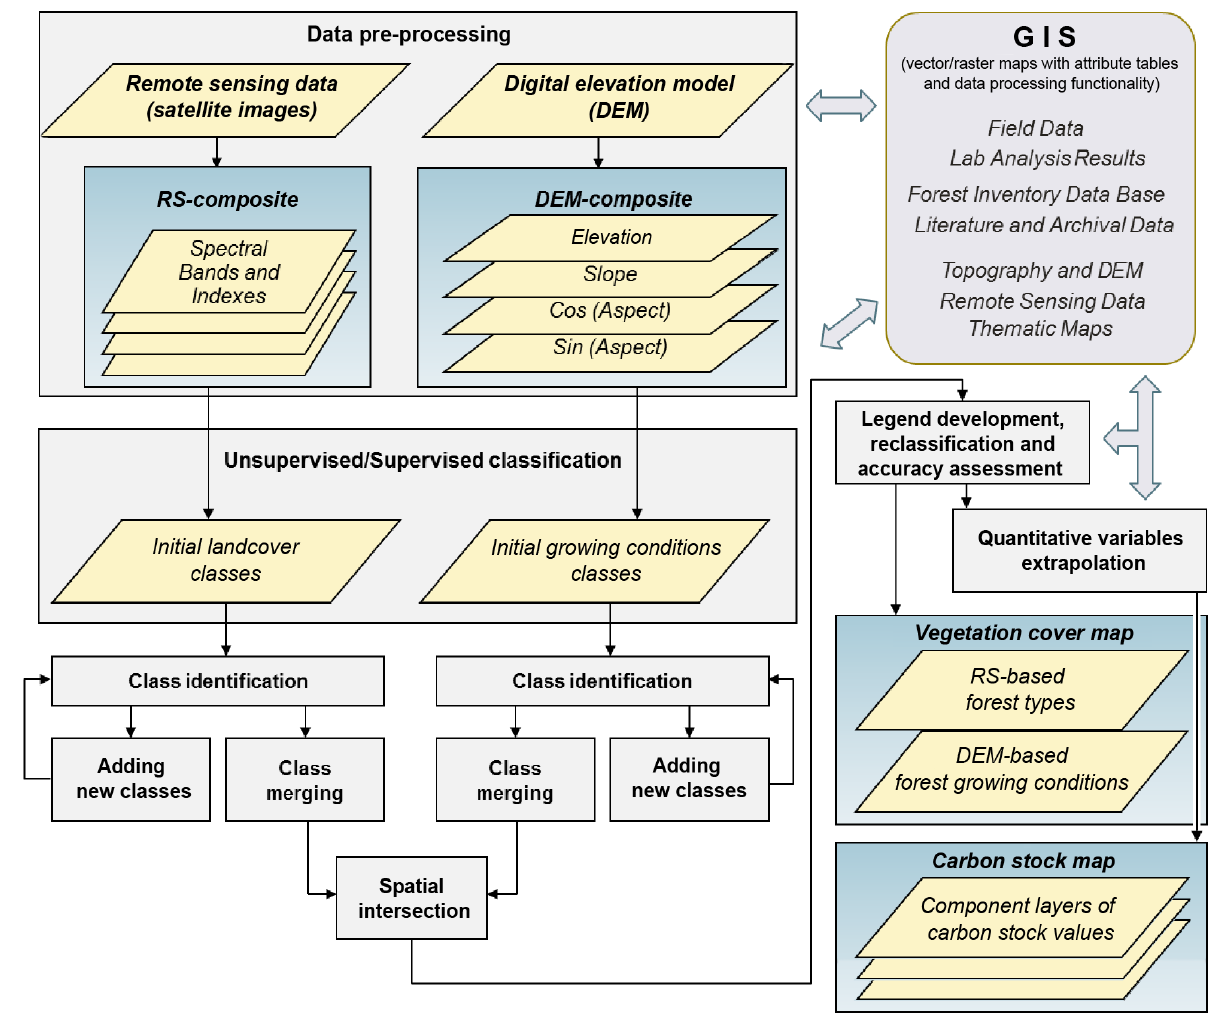
Figure 2. Data processing